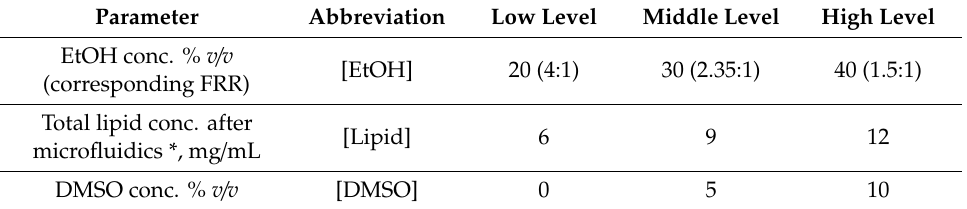
Table 1. A design of experiments (DoE) with CAF09b was designed with the parameters concentration of EtOH [EtOH], total lipid concentration after microfluidics [Lipid] and DMSO concentration [DMSO]. FRR: Flow rate ratio. Parameter Abbreviation Low Level Middle Level High Level EtOH conc. % v / v [EtOH] 20 (4:1) 30 (2.35:1) 40 (1.5:1) (corresponding FRR) Total lipid conc. after [Lipid] 6 9 12 microfluidics *, mg / mL DMSO conc. % v / v [DMSO] 0 5 10 * The concentration of lipids (DDA and MMG) in the formulation after assembly on microfluidics but prior to dilution. However, the dilution was immediate in the collection vial and resulted in a final lipid concentration